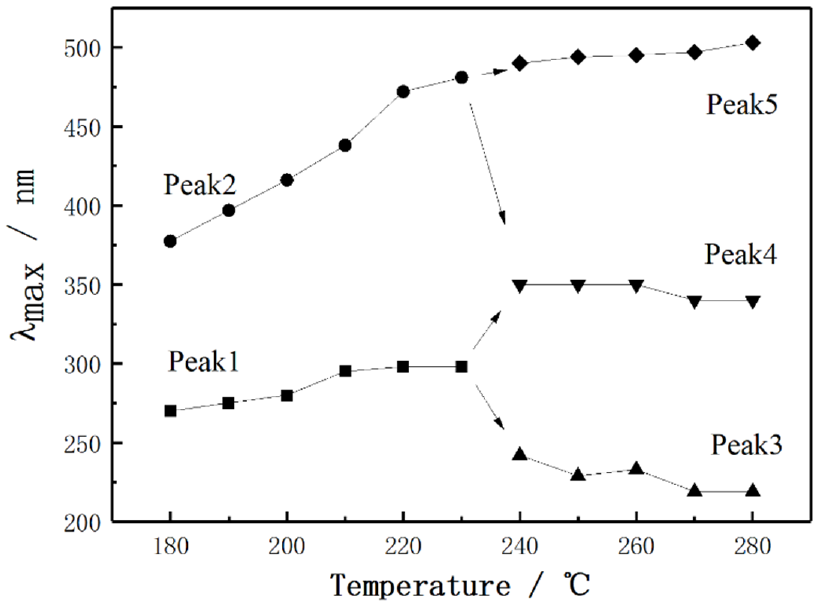
Figure 5. Variation of the λ max position corresponding to the UV-vis absorption spectrum of PAN fibers during stabilization process.